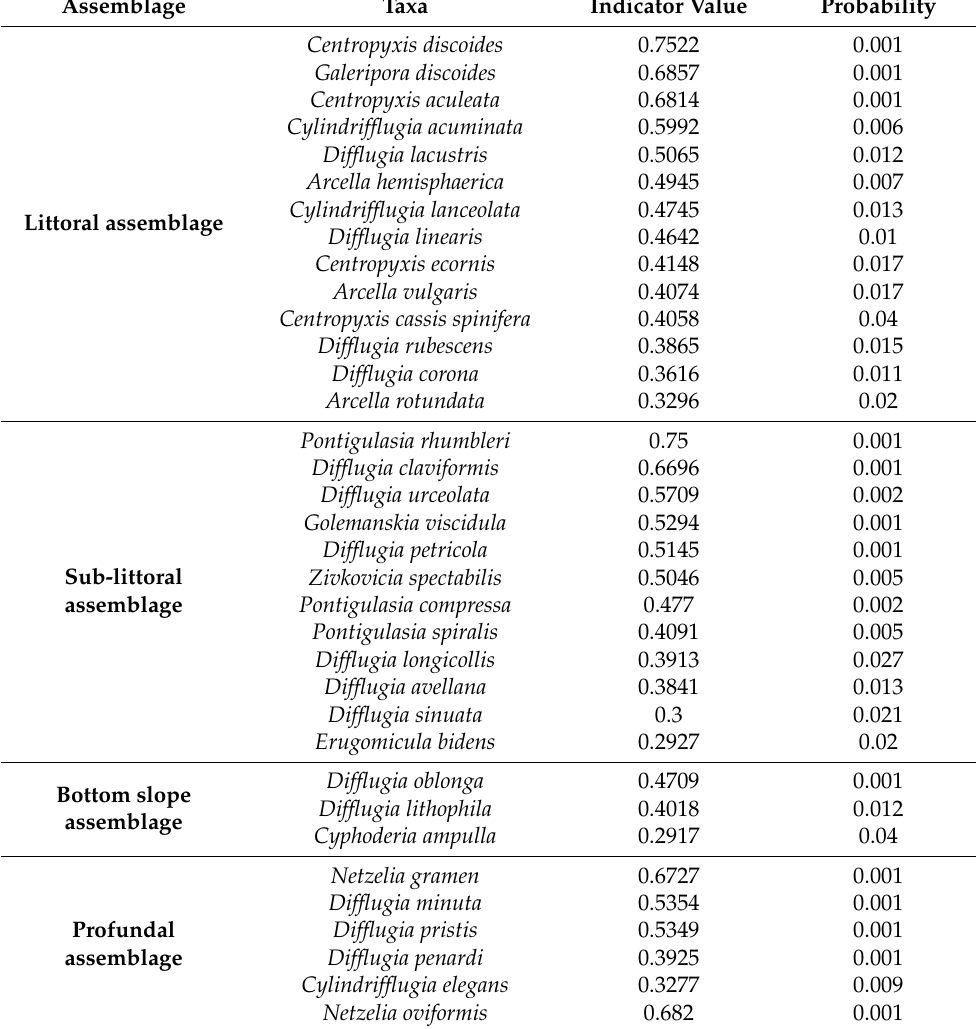
Table 2. Indicator species of four assemblages along the sampling depth gradient.